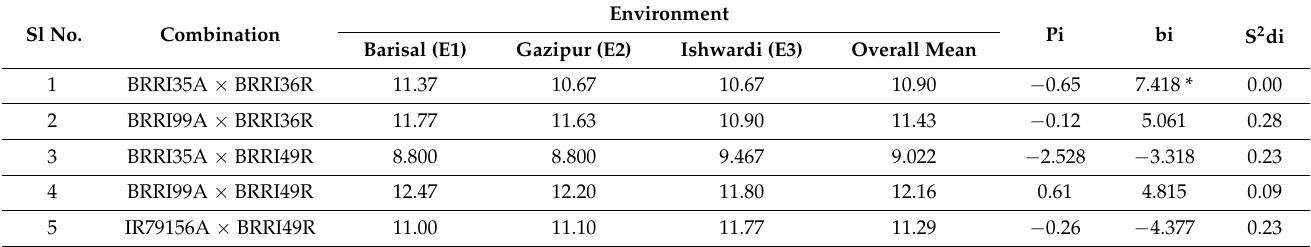
Table 6. Stability analysis for effective tillers/hills of 26 hybrid combinations at three